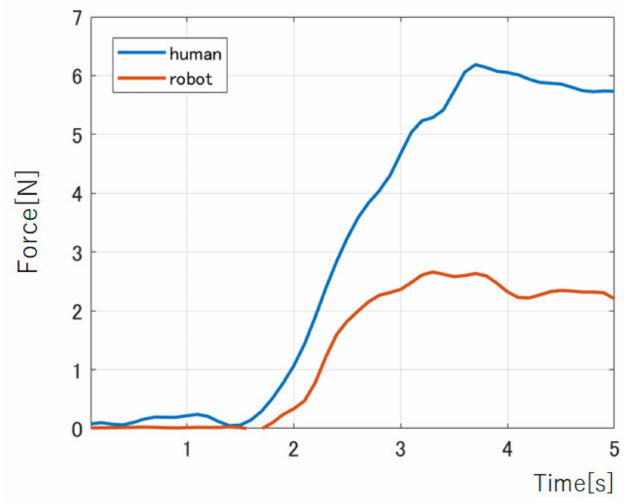
Figure 11. The index force of human and the prosthetic